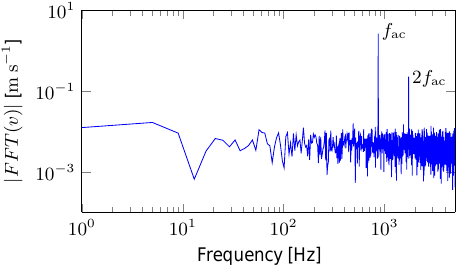
Figure 14. Amplitude spectrum of the flow velocity v y at